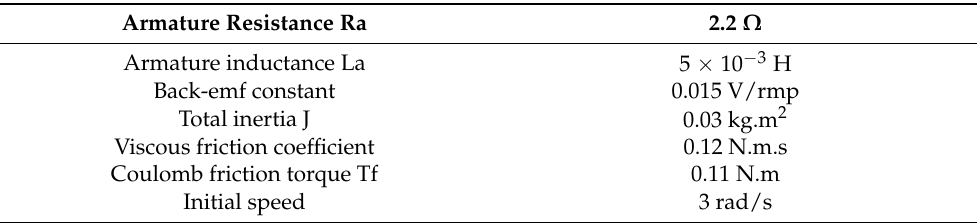
Table A3. DC motor